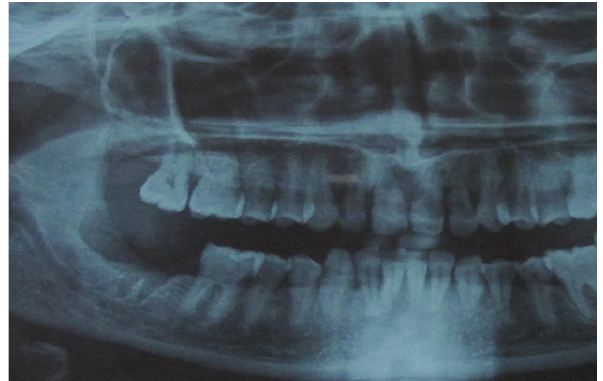
Figure 6: Radiographic appearance of persistent bony lucency in third molar and retromolar area after three